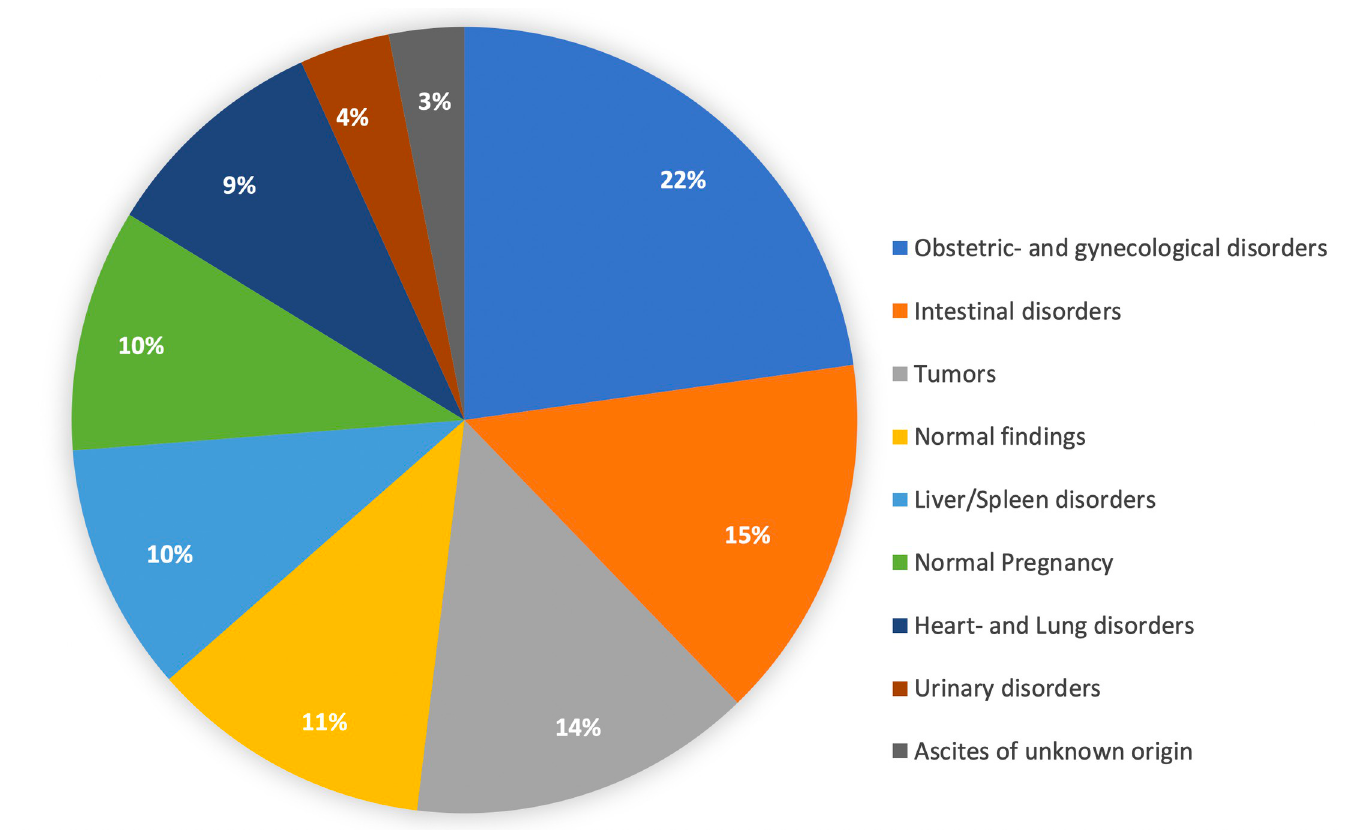
Fig 1. A total of 1326 diagnoses in 1130 non-trauma patients who received abdominal ultrasound. The percentages refer to the number of diagnoses.